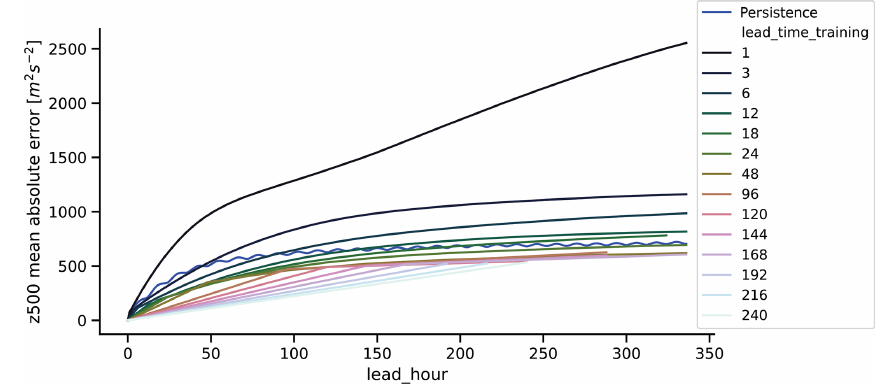
Figure 8. Mean absolute error of 500hPa geopotential height for networks trained on coarse-grained (T21) ERA5 data. The training was performed on different lead times. The x axis denotes the lead time of the forecast in hours and the colors the lead time used for training (in hours). Also shown is the persistence forecast (thick blue